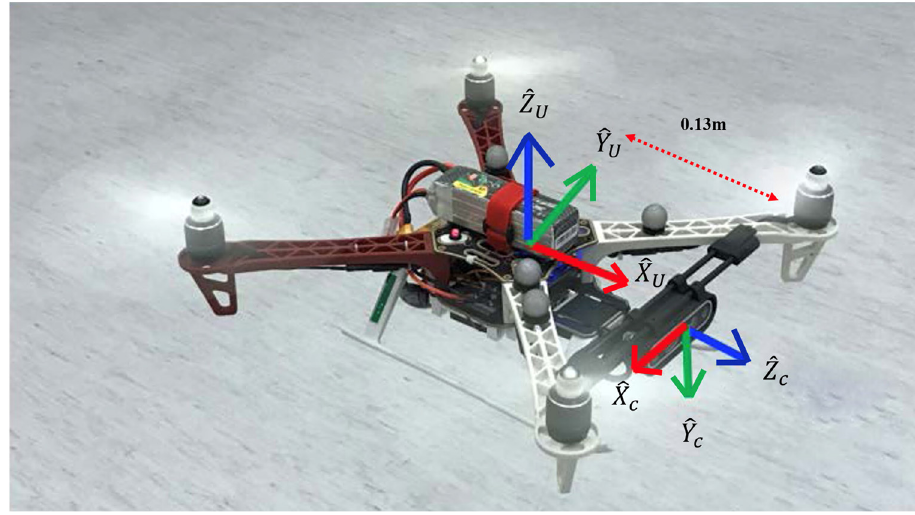
Figure 12. Visualization of camera coordinate and UAV body coordinate.